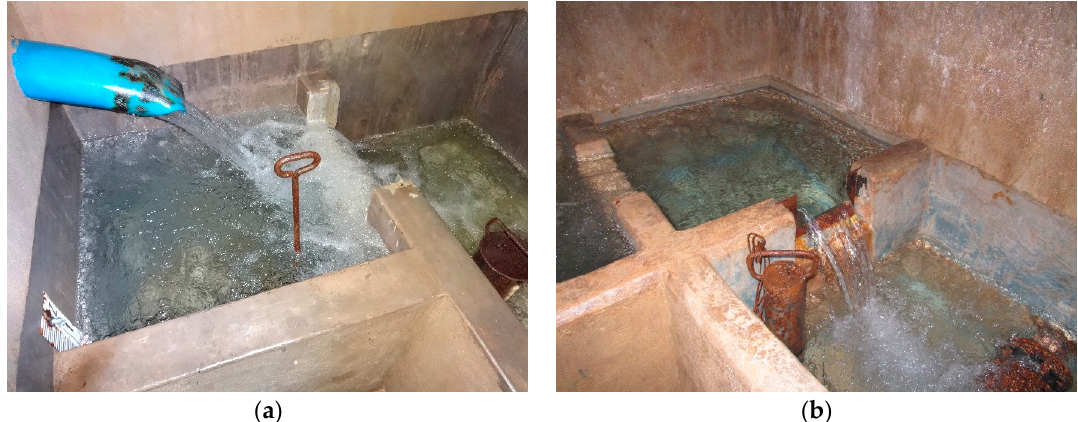
Figure 4. Water sources of Fatra Spring near Ľ uboch ň a municipality ( a ) and Pod Kopou Spring near Kra ľ ovany ( b ). Technical details of the capture method.